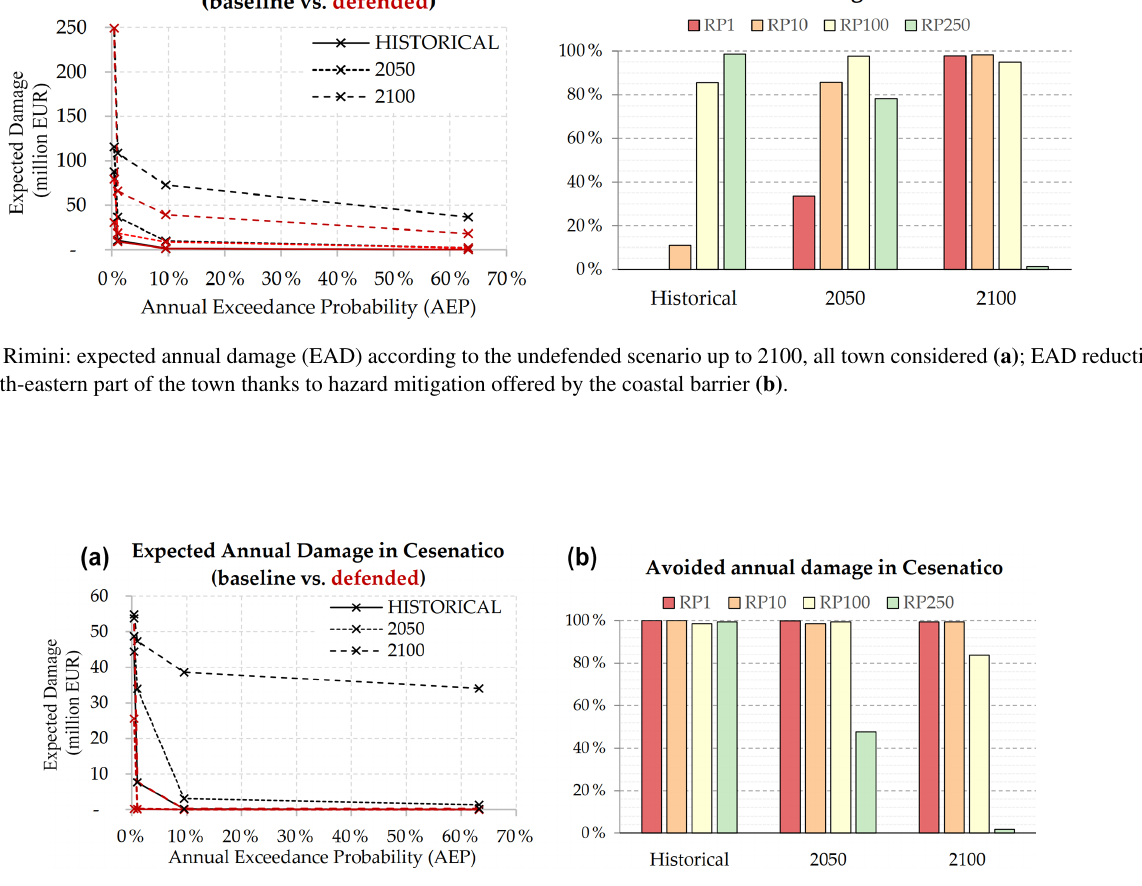
Figure 10. Cesenatico: expected annual damage (EAD) according to the undefended scenario up to 2100 (a) ; EAD reduction thanks to hazard mitigation offered by the coastal barrier (b) .